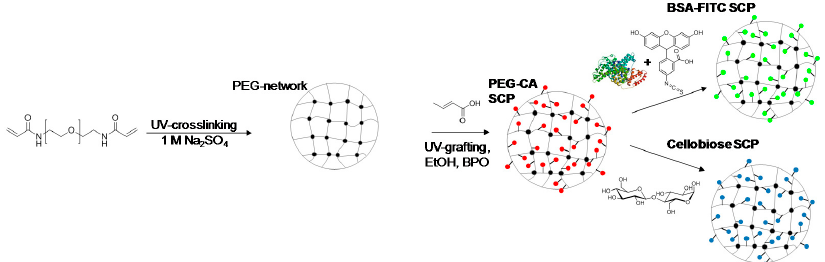
Figure 2. Sythetic route toward bovine serum albumin-fluoresceine isothiocyanate (BSA-FTIC) SCPs and cellubiose SCPs based on PEG-dAAm microgels.